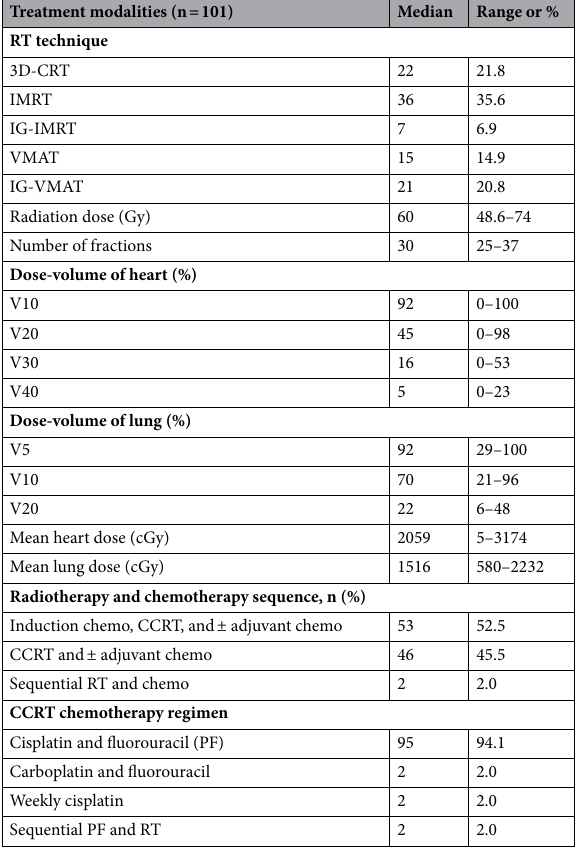
Table 2. Treatment modalities. Vx(%) relative percent of volumes for at least x (Gy), 3DCRT 3-dimensional conformal radiation therapy, IMRT intensity-modulated radiation therapy (IMRT), VMAT volumetric modulated arc therapy, IG image-guided, CCRT concurrent chemoradiation.